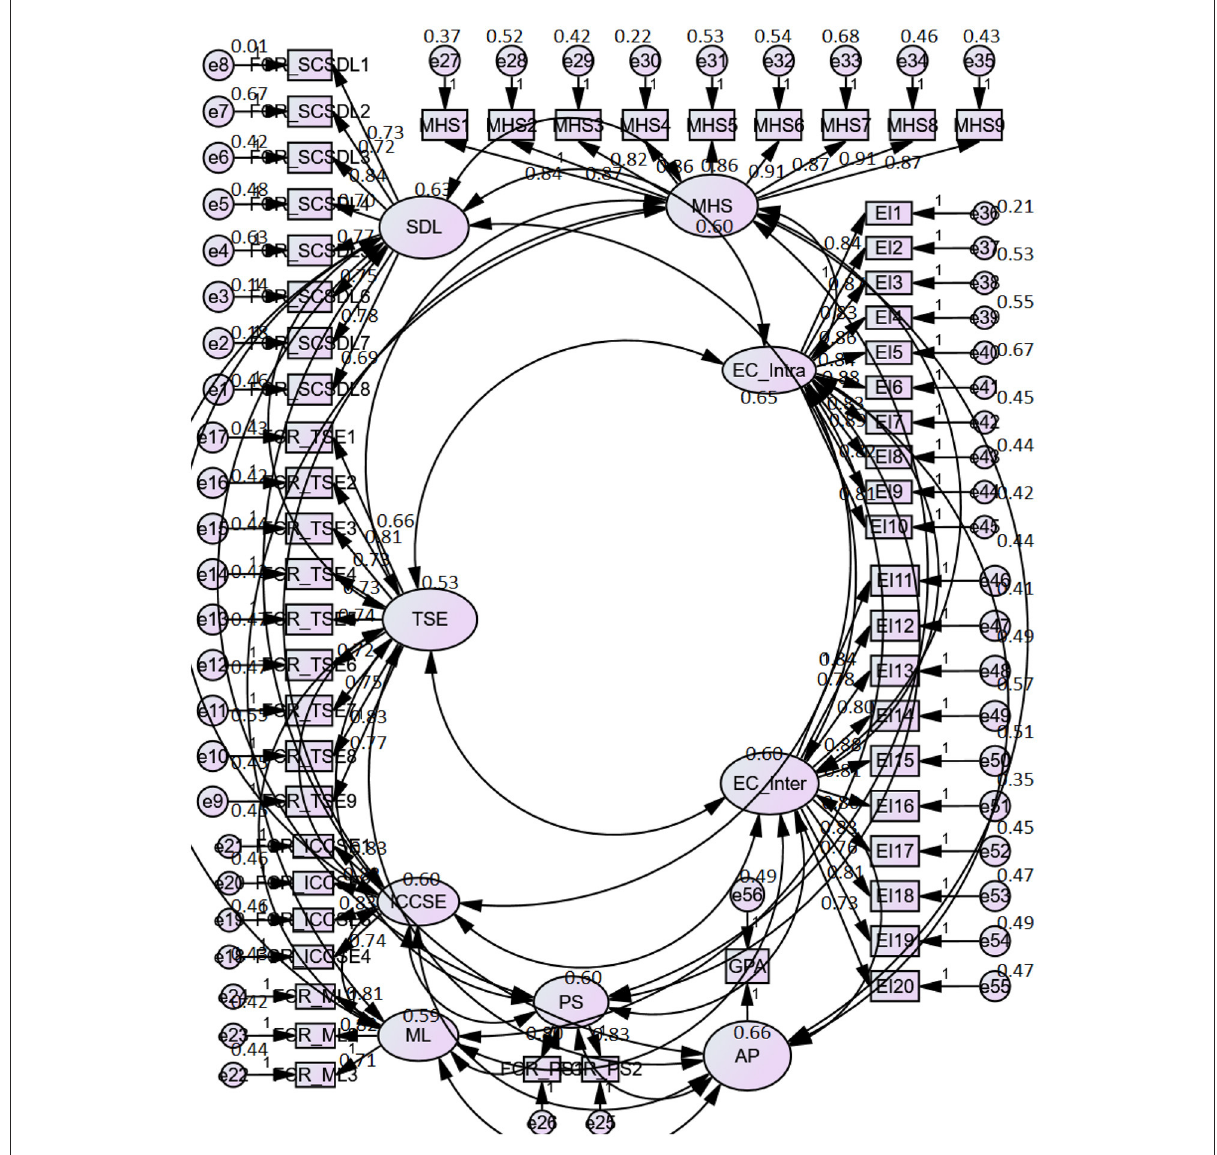
FIGURE2 Measurement